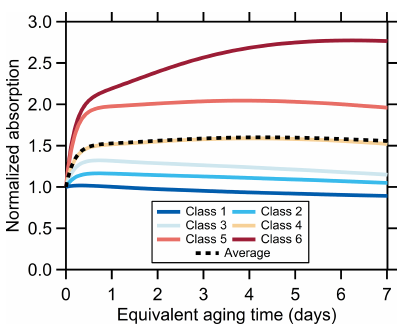
Figure 7. Modeled change in the absolute absorption with aging, assuming no dilution, normalized to the value at t = 0. Results are shown for each particle class (colors) and the average (black).